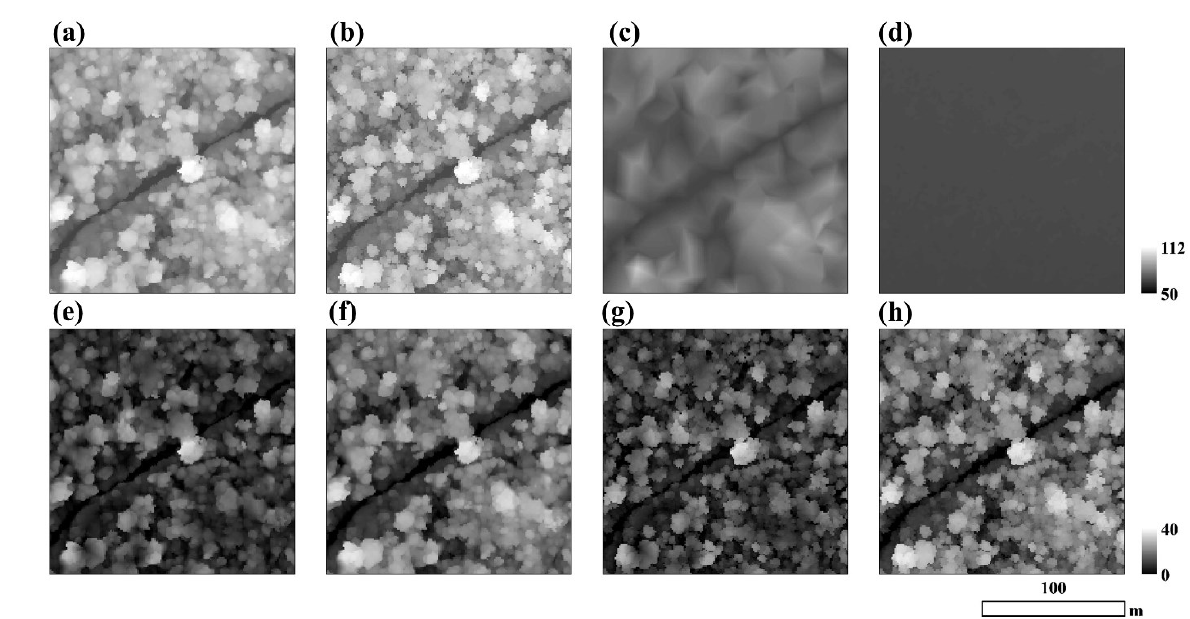
Figure 2. Representative samples of DSM, DTM, and CHM. ( a ) DSM P ; ( b ) DSM L ; ( c ) DTM P ; ( d ) DTM L ; ( e ) CHM PP ; ( f ) CHM PL ; ( g ) CHM LP ; ( h ) CHM LL